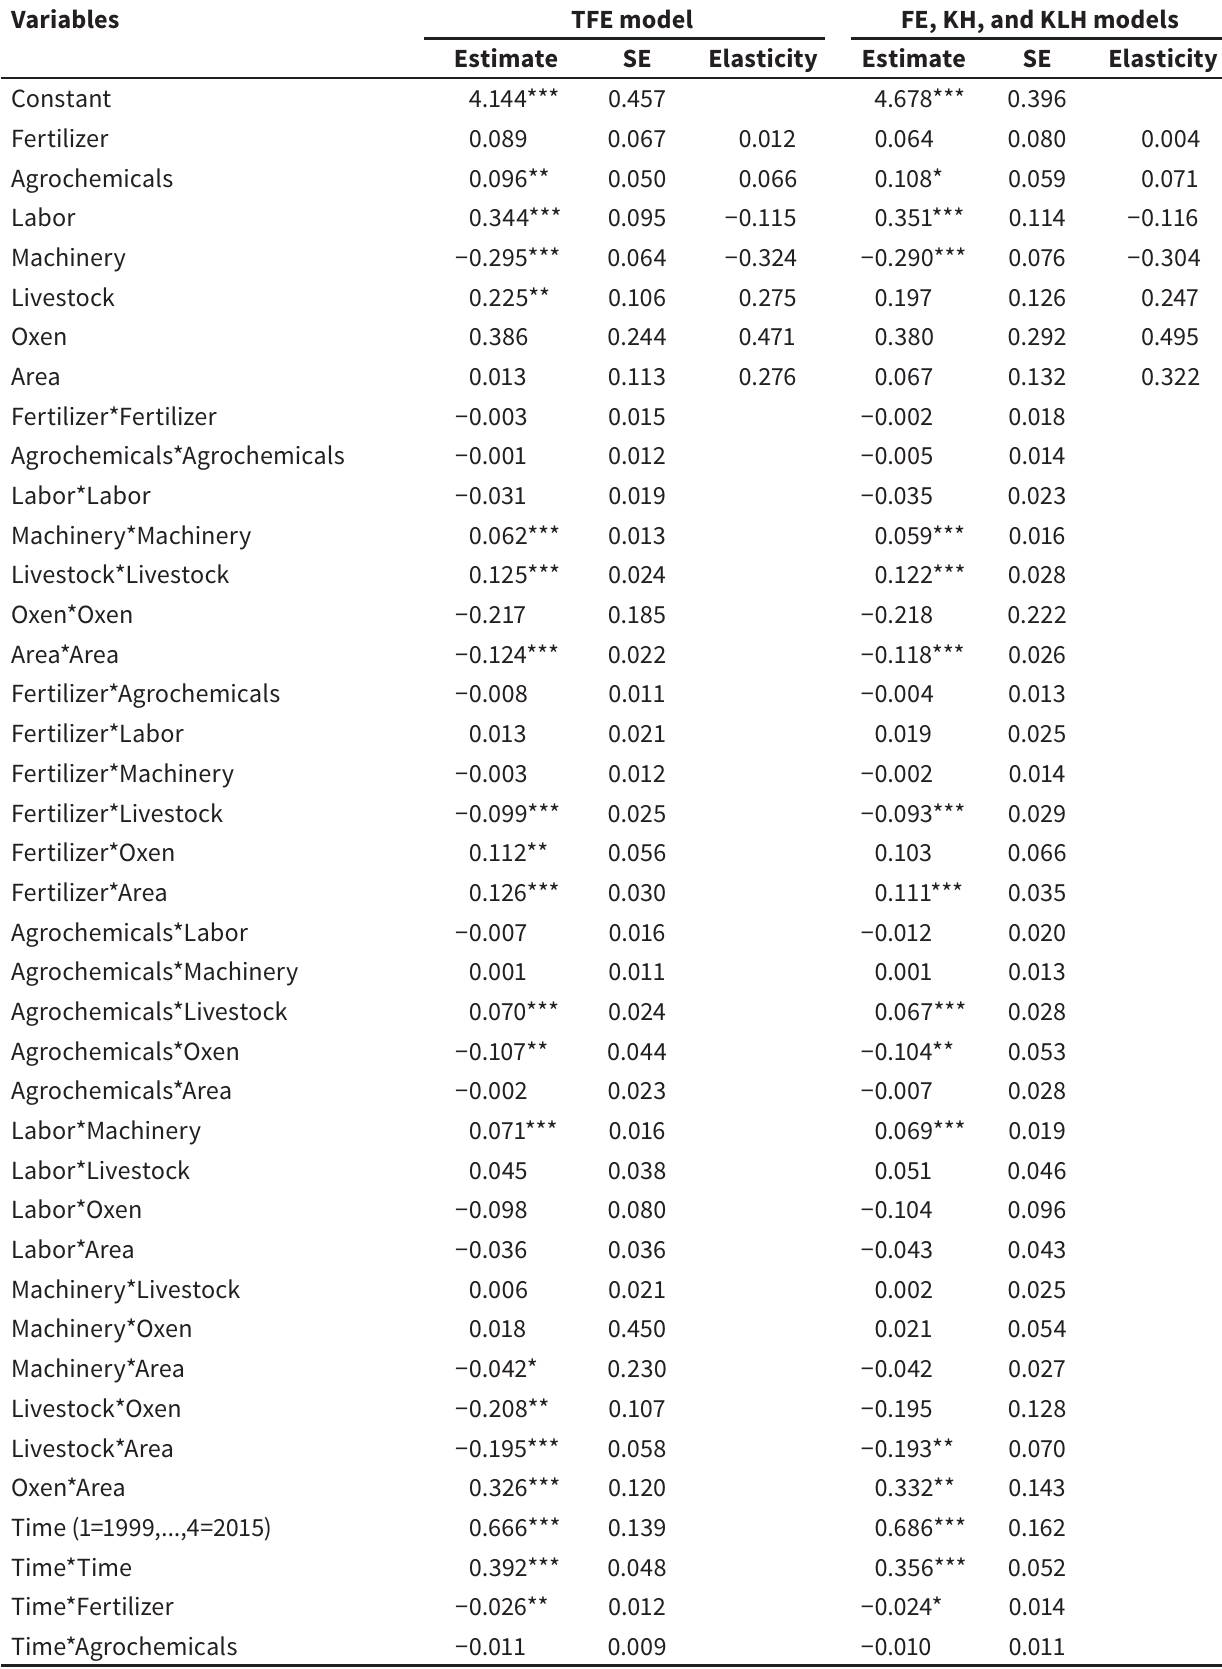
Estimates of the Parameters, Elasticities, TC, and RTS across Models (NT =